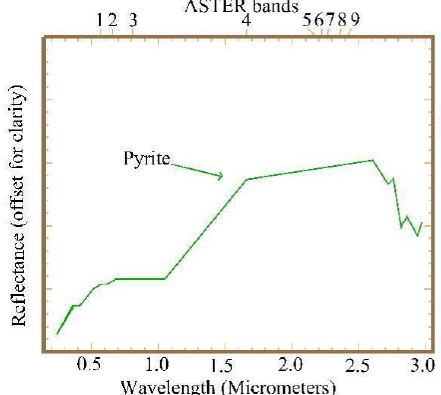
Figure 3. Laboratory spectra of pyrite resampled to aster bandpasses. Pyrite has 1.165 and 1.10 μm absorption features (Produced by the author, after Clark et al.,